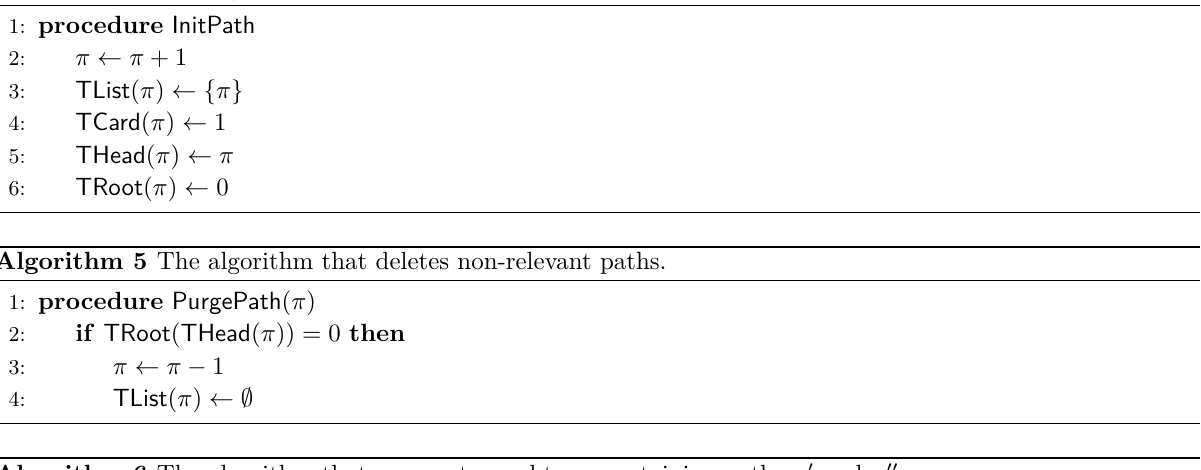
Algorithm 4 The algorithm that initializes a new oriented path.